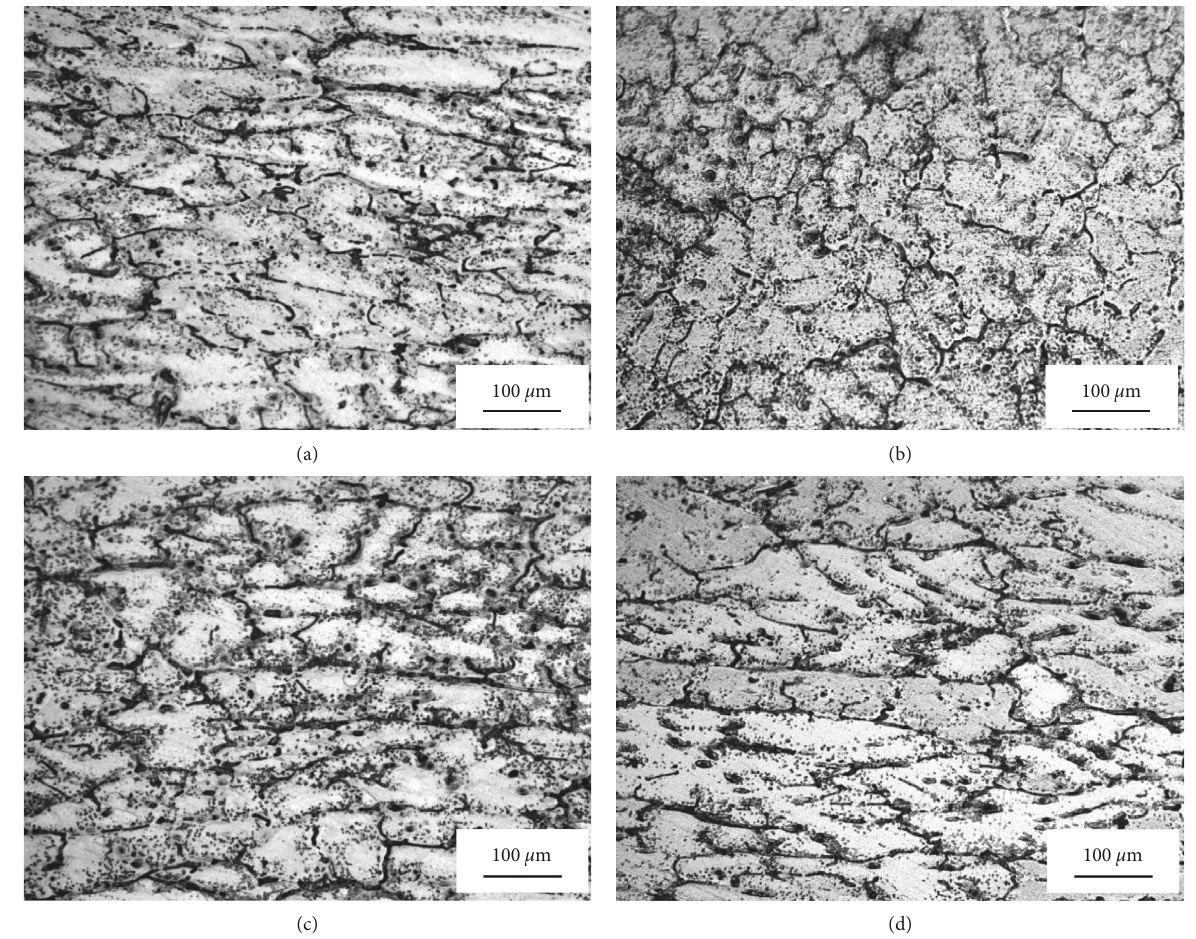
Figure 2: Microstructures of the AA6061 alloy after PSC under different conditions: (a) 400 ° C/5 s − 1 ; (b) 350 ° C/0.01s − 1 ; (c) 400 ° C/0.01s − 1 ; and (d) 300 ° C/5 s − 1